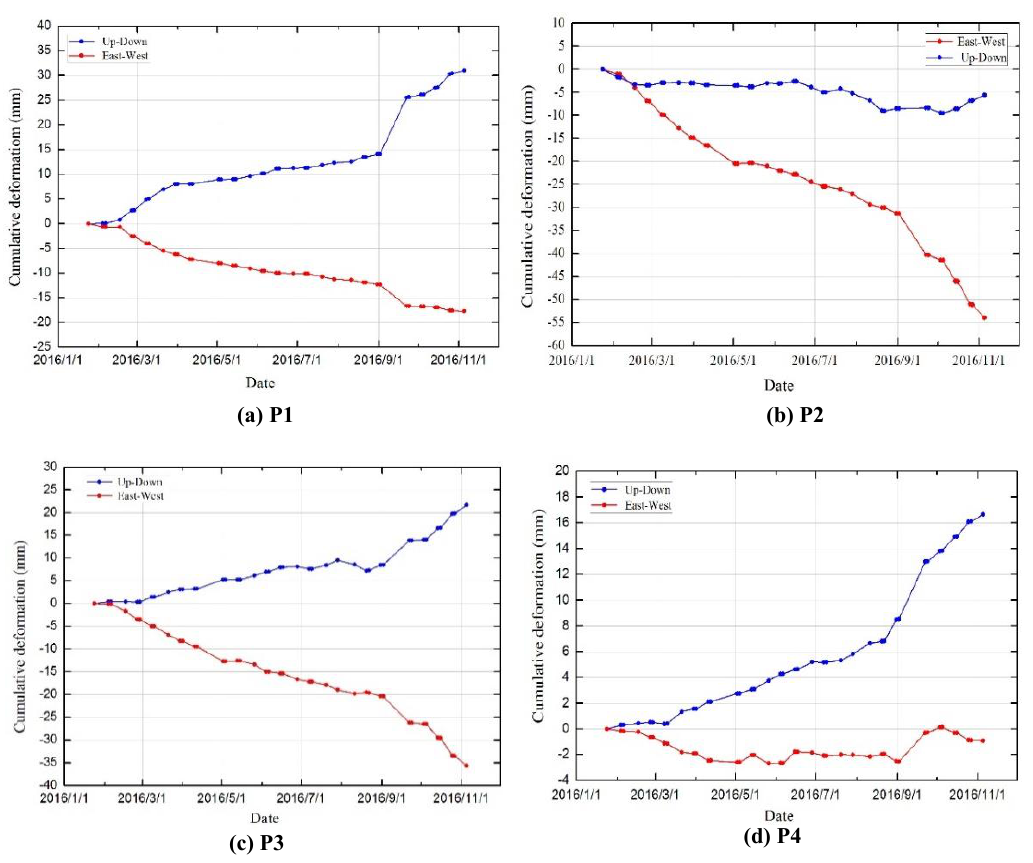
Figure 4. Time series deformation in vertical and east-west direction of Xinyuan No.2 landslide for points P1 to P4 shown in Figure 1(c) calculated with MSBAS technique.